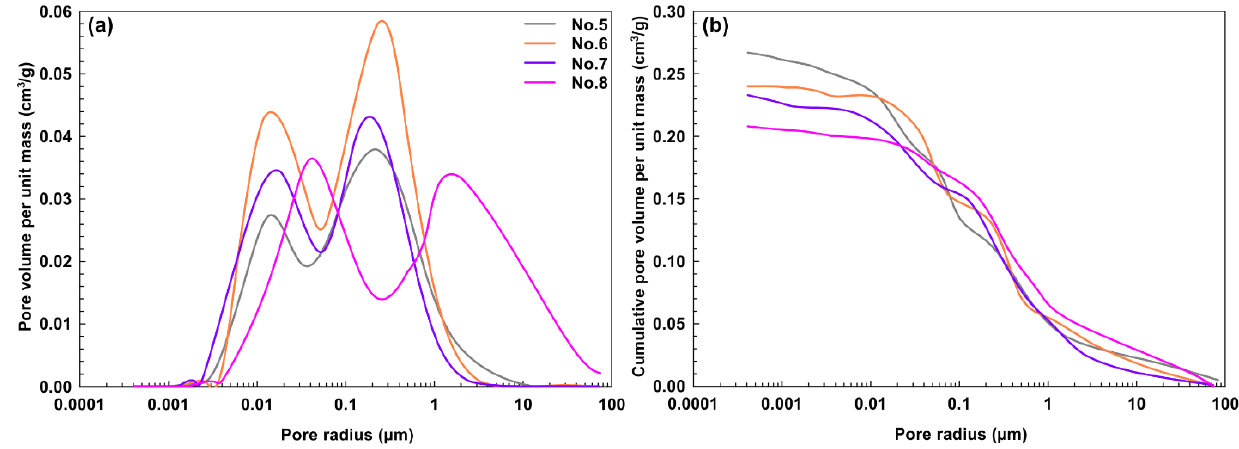
Figure 15. ( a ) Differential and ( b ) cumulative PSDs of silty samples (taken from Adapazar ı ).